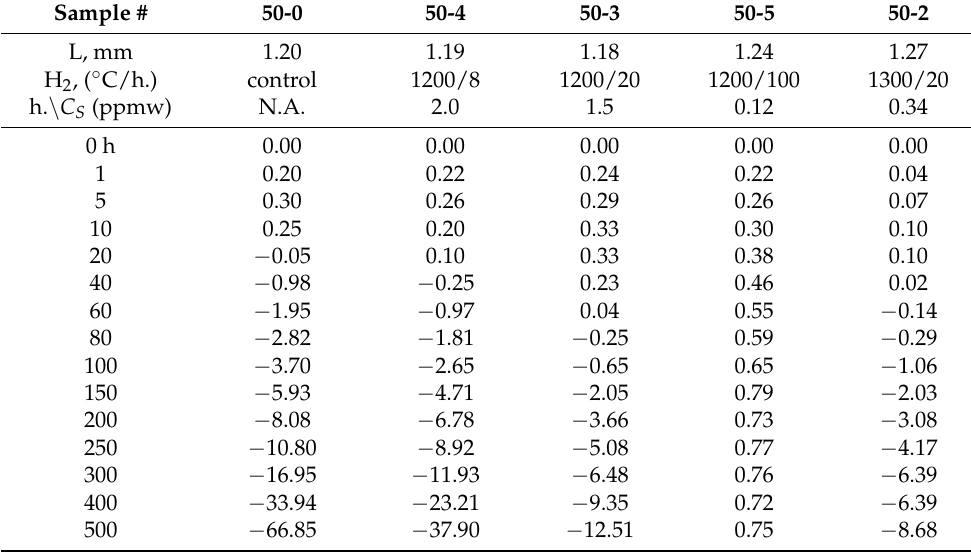
Table 3. Cyclic-oxidation specific weight change data for “50 mil” PWA 1480 samples (1100 ◦ C for 500 h in air). Effect of hydrogen annealing time and temperature. Measured sulfur content ( C S ) after hydrogen annealing; thickness (L) measured after polishing and before oxidation